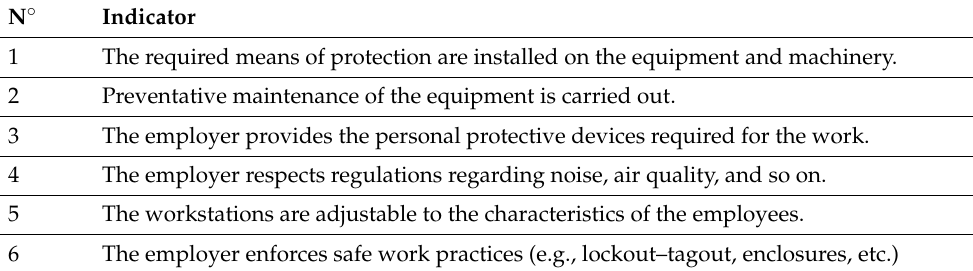
Table 2. Indicators used in the IRSST tool (translated from